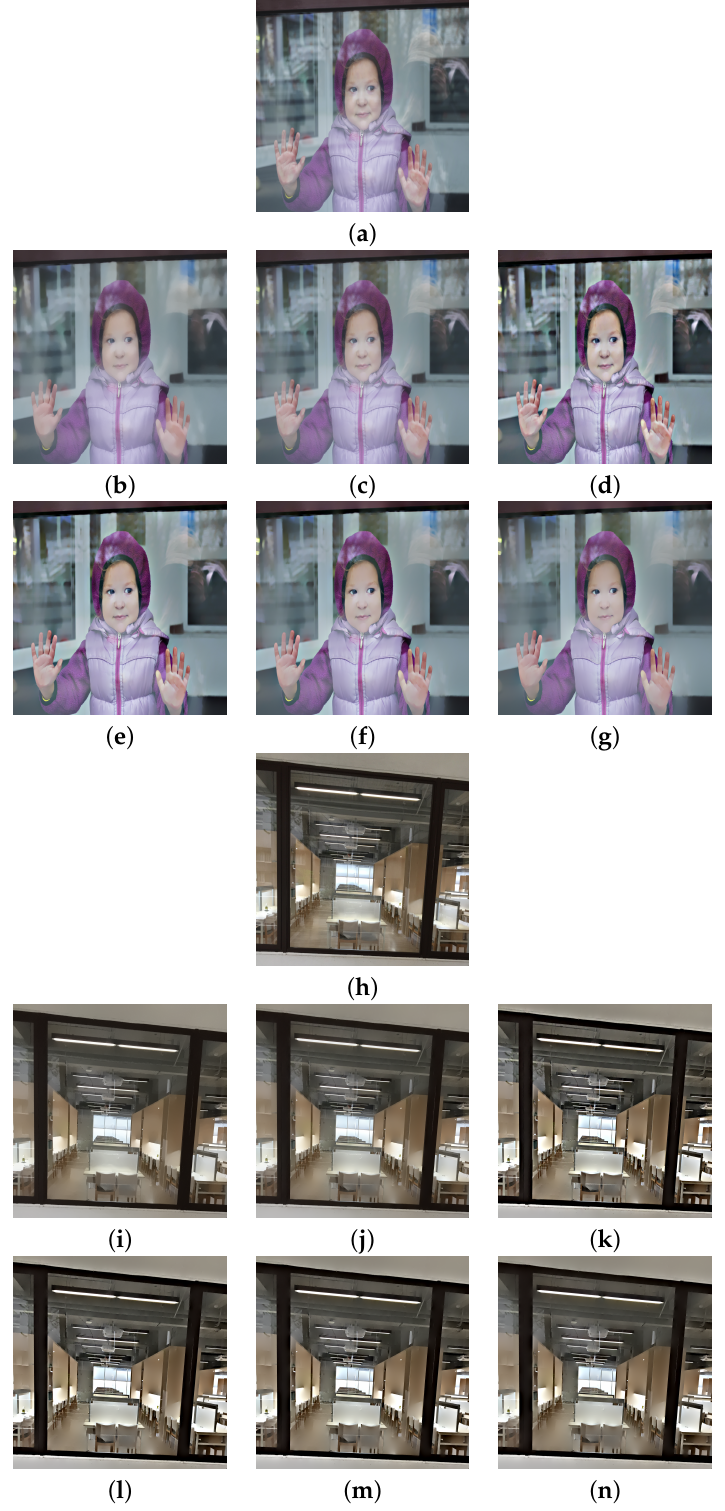
Figure 8. Reflection suppression results for real glass images ‘Child’ and ‘Library’. ( a , h ) Input images. ( b , i ) The results of algorithm [2]. ( c , j ) The results of algorithm [3]. ( d , k ), ( e , l ), ( f , m ), and ( g , n ) are results of the proposed algorithm with N = 1,2,3,4,